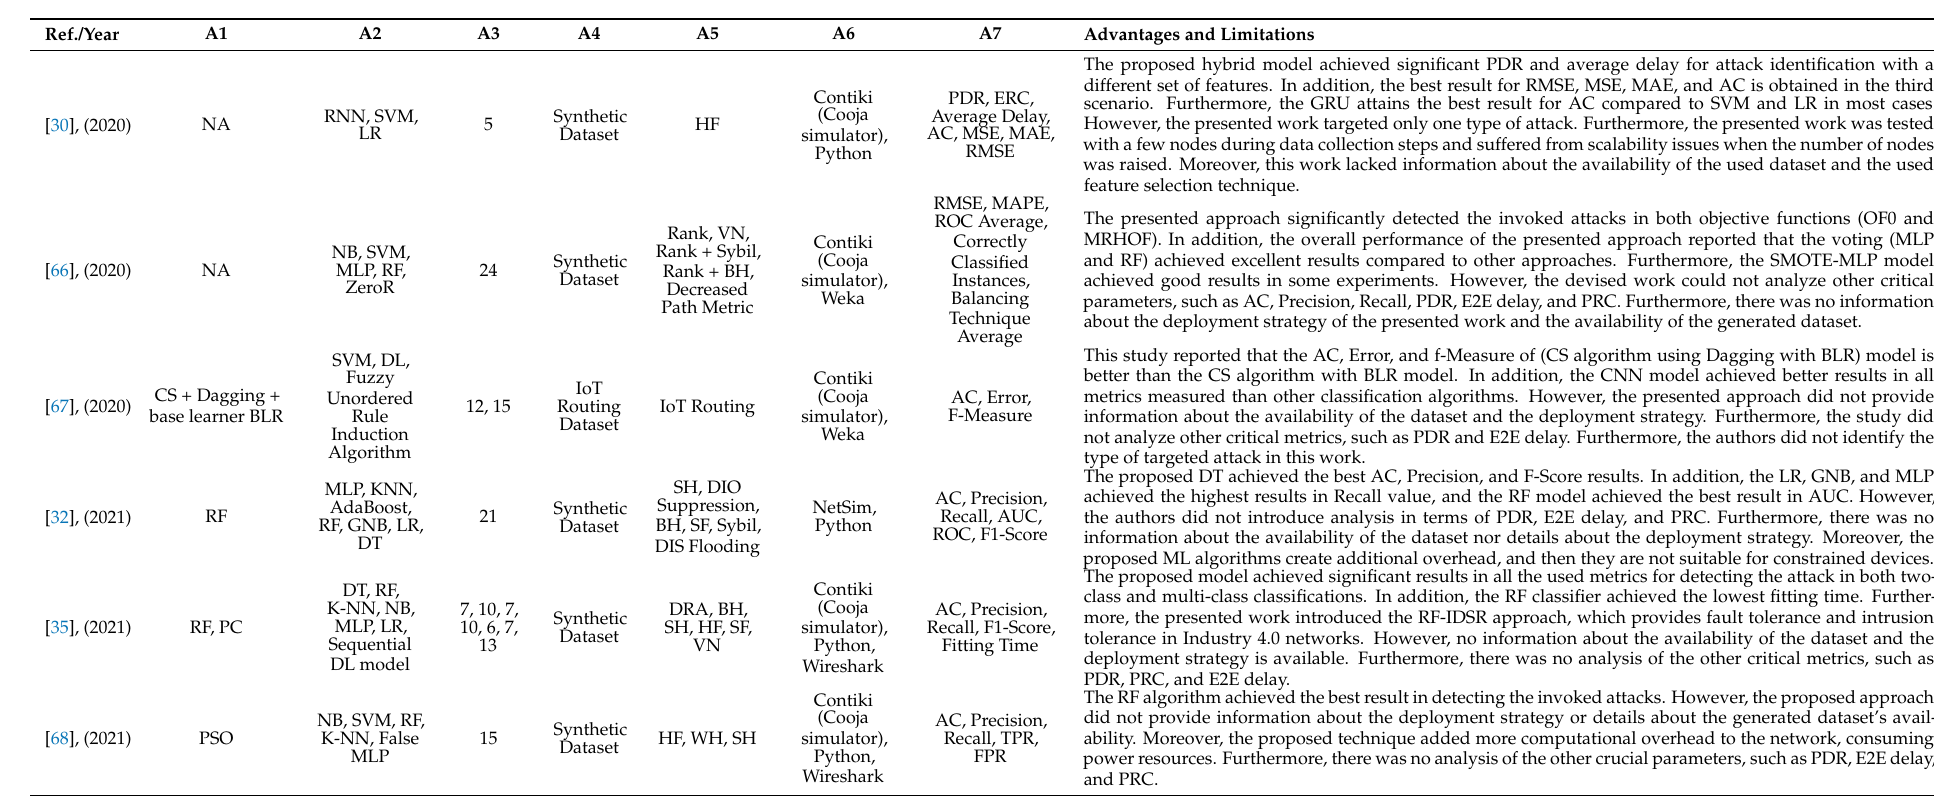
Table 4. Summary of combined ML- and DL-based